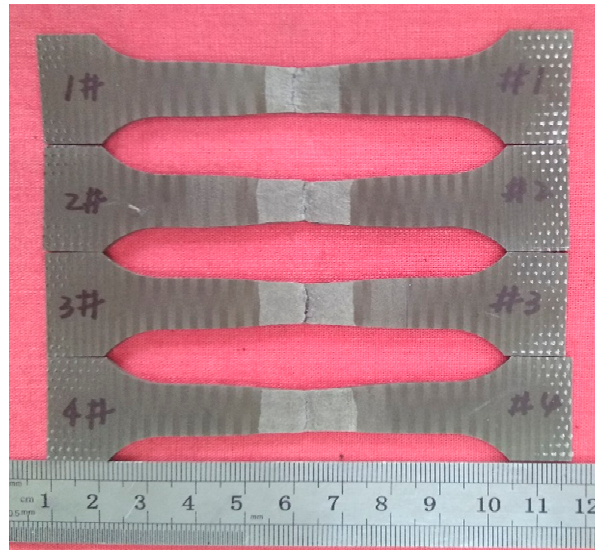
Figure 9. The fracture positions of the tensile specimens.